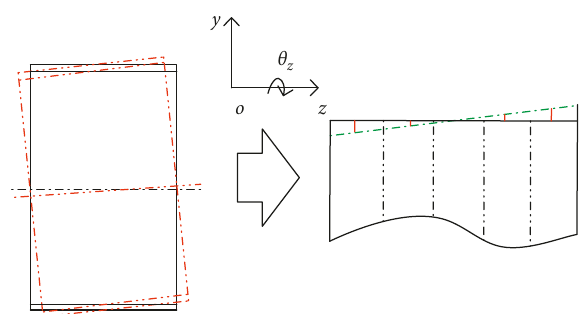
Figure 3: Influence of installation shaft error on helical gear meshing gear